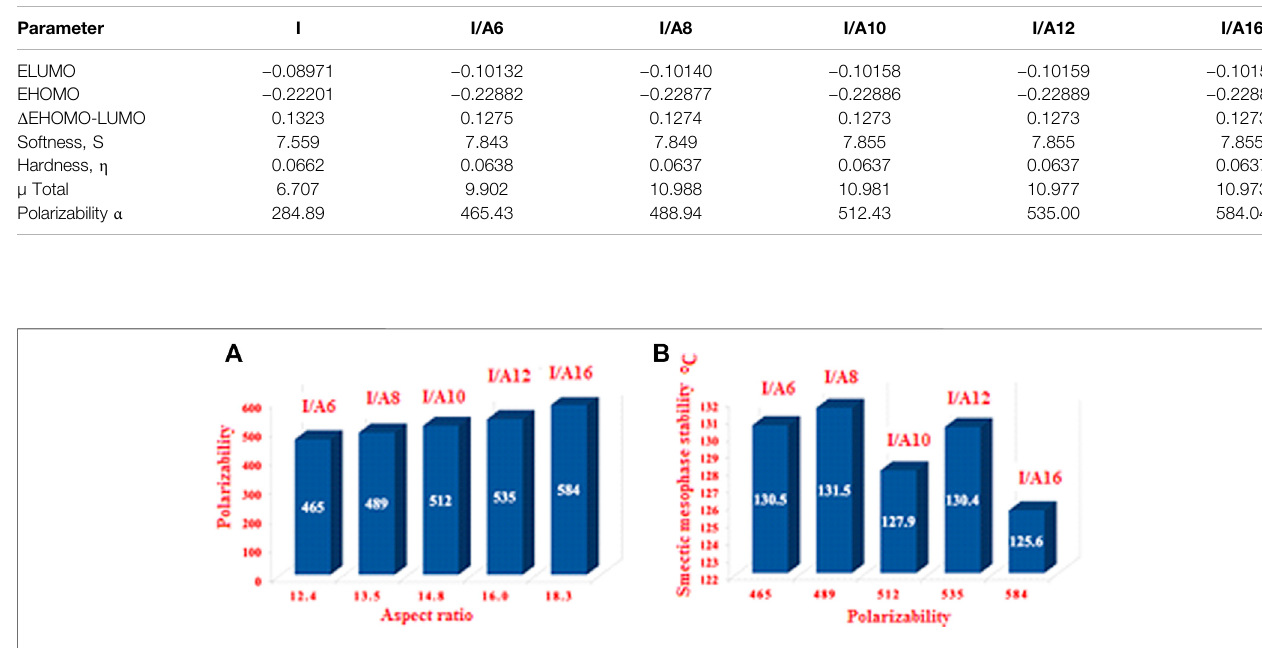
FIGURE 15 | The relationship between the polarizability and the aspect ratio (L/D) of all prepared compounds (A) ; and polarizability dependence relationship with the length of alkoxy chains (B) .